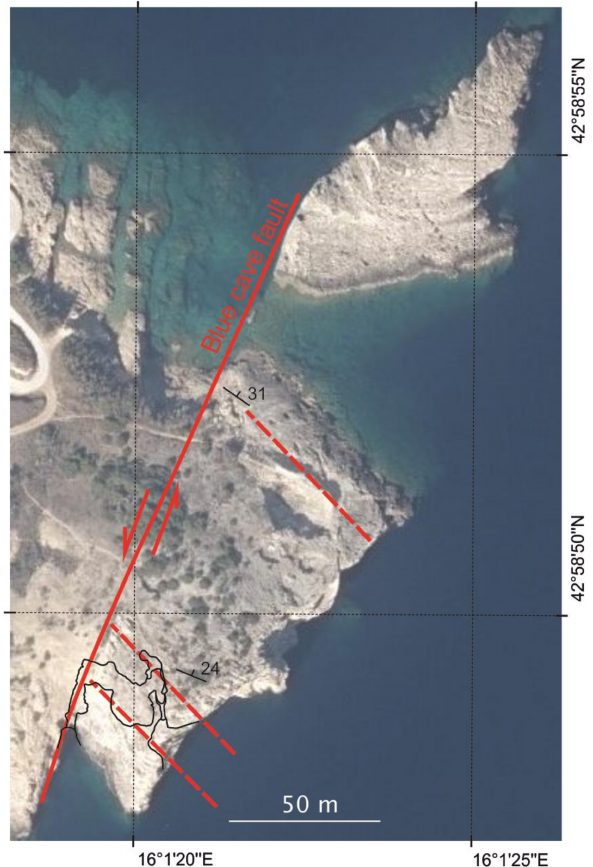
Figure 8. Satellite image of the Blue Cave area, with overlapped plan of the cave (black outline). The red line marks a position of the Blue Cave fault observed on the surface. Dashed red lines mark the position of the fracture system observed in the cave and on the surface; the black marks indicate the dip direction and dip angle (number) of the bedding (same as in Figure 2). The satellite image was acquired from: http://www.arkod.hr/, accessed on 4 July